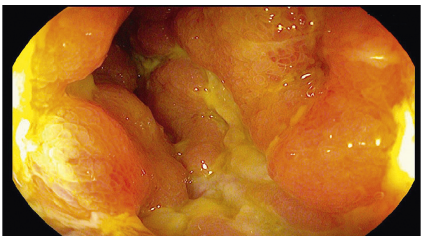
Figure 1: Colonoscopy showing severe ileal serpiginous ulceration and diffuse ileitis (Rutgeerts classification i4) before starting vedolizumab and ustekinumab therapy.